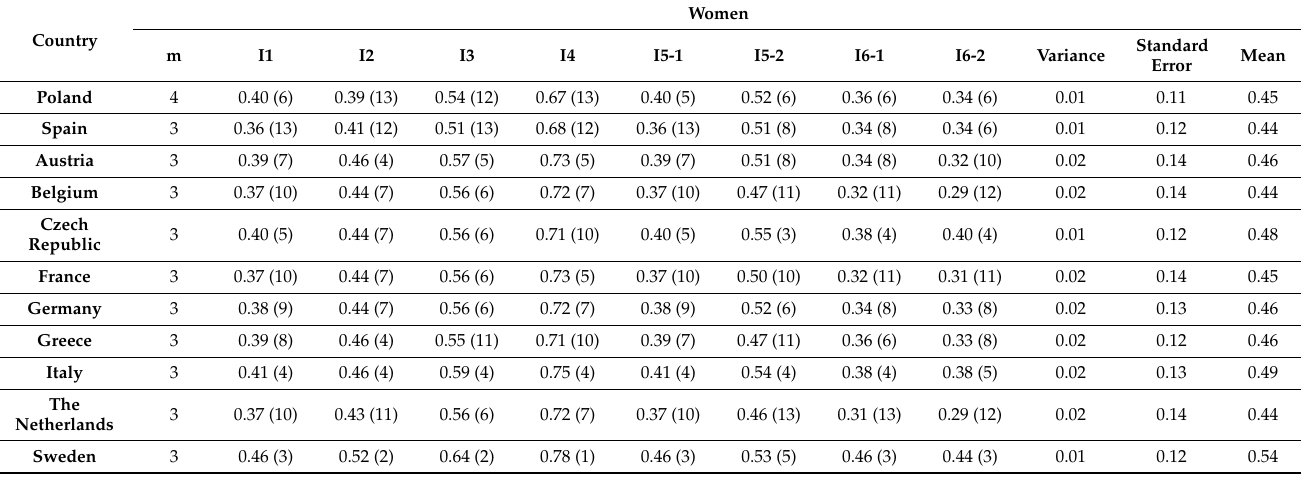
Table 6. Inequality indicators in self-perceived health in Wave 2 (2006) for